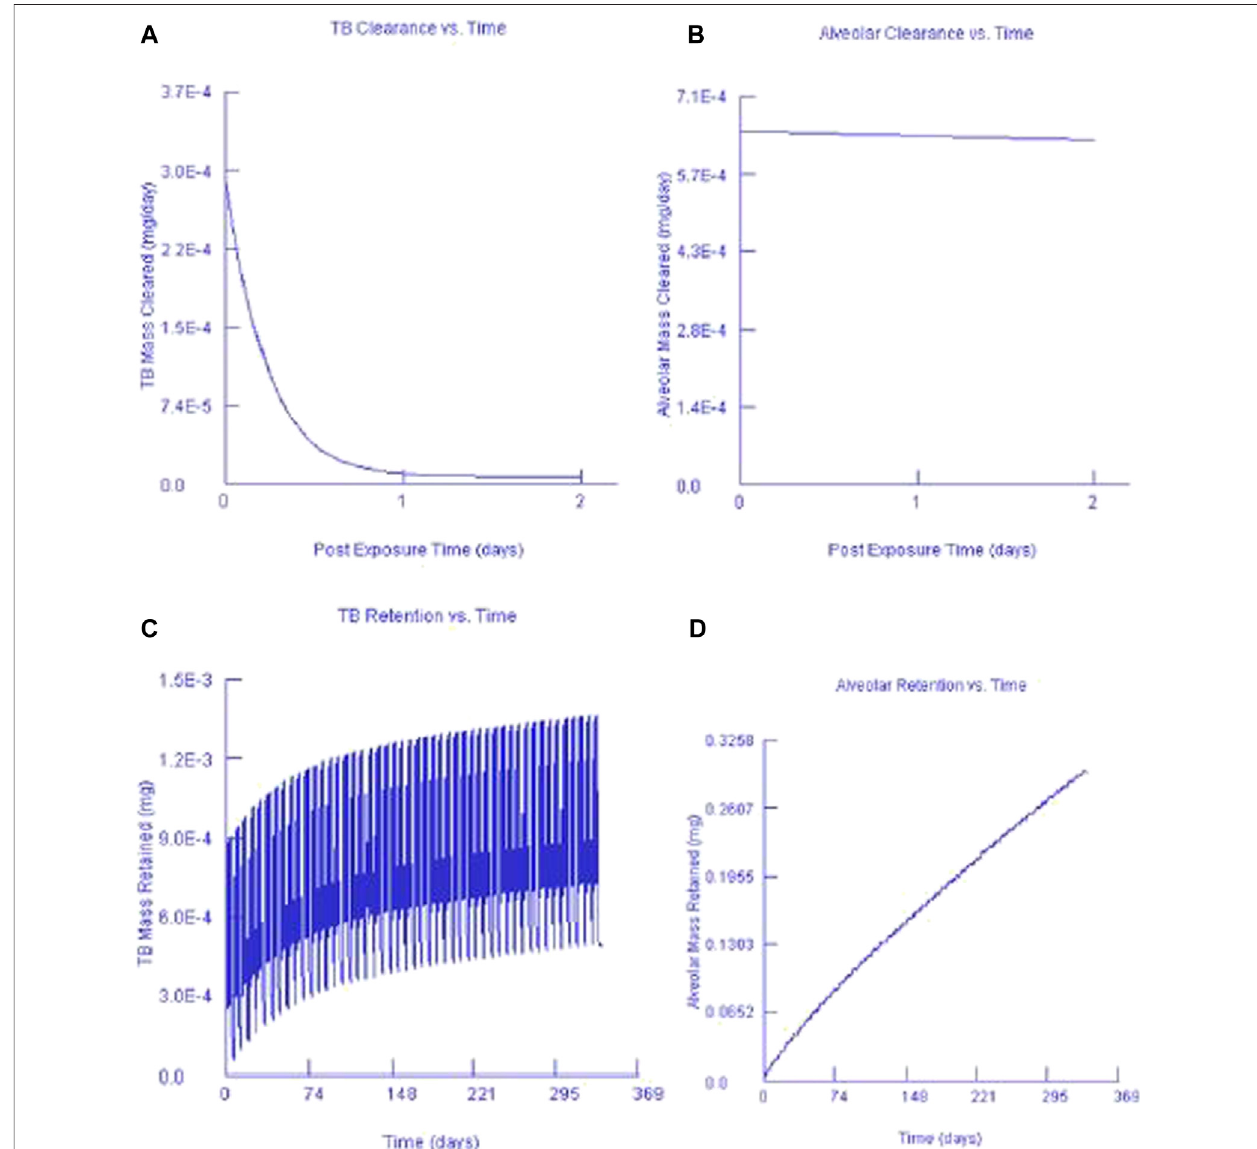
FIGURE8| SilvernanoparticlesandtheircorrespondingTBclearance (A) andalveolarclearance (B) forsimulatedpost-exposureaswellastheirTBretention (C) and alveolar retention (D) for simulated continuous exposure.